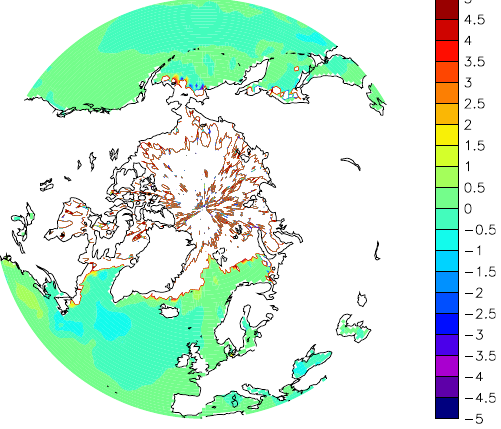
Fig. 2. As Fig. 1 (left) but for sea surface temperatures from HadISST1 dataset as used in the simulation